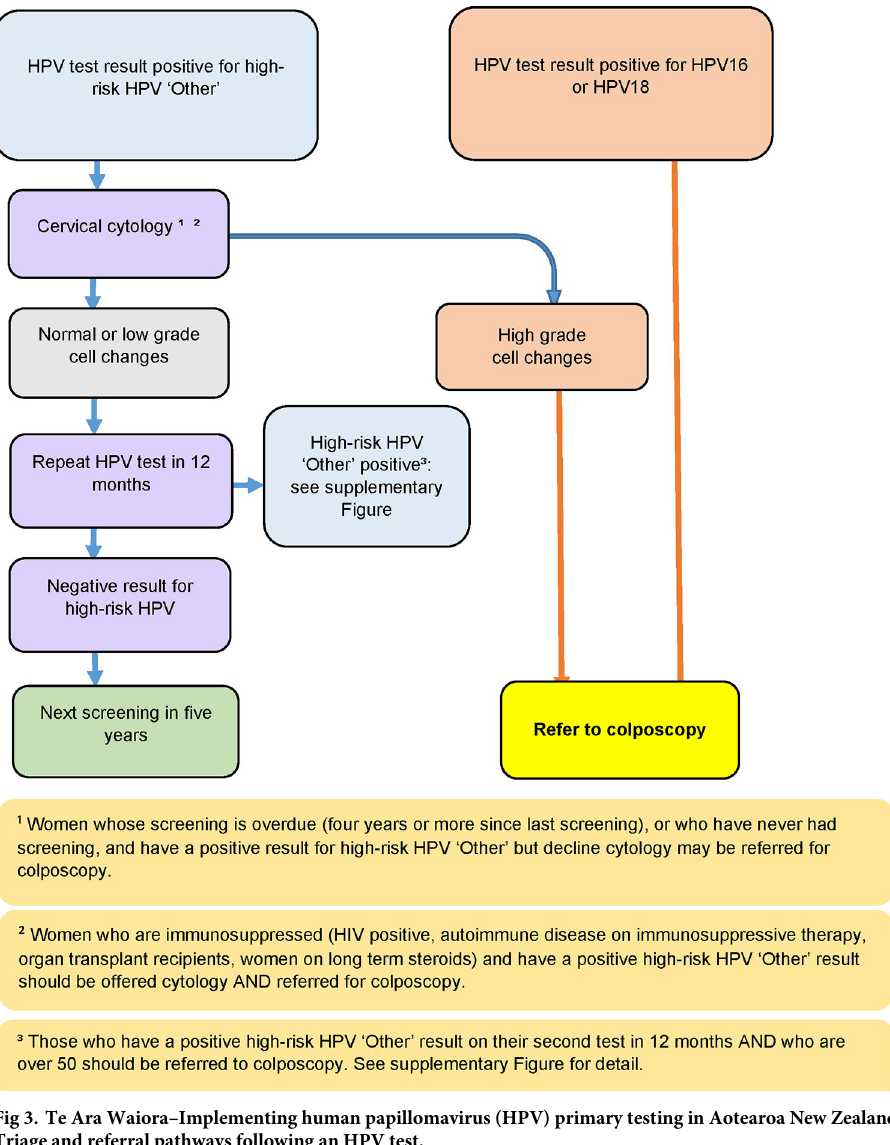
Fig 3. Te Ara Waiora–Implementing human papillomavirus (HPV) primary testing in Aotearoa New Zealand: Triage and referral pathways following an HPV